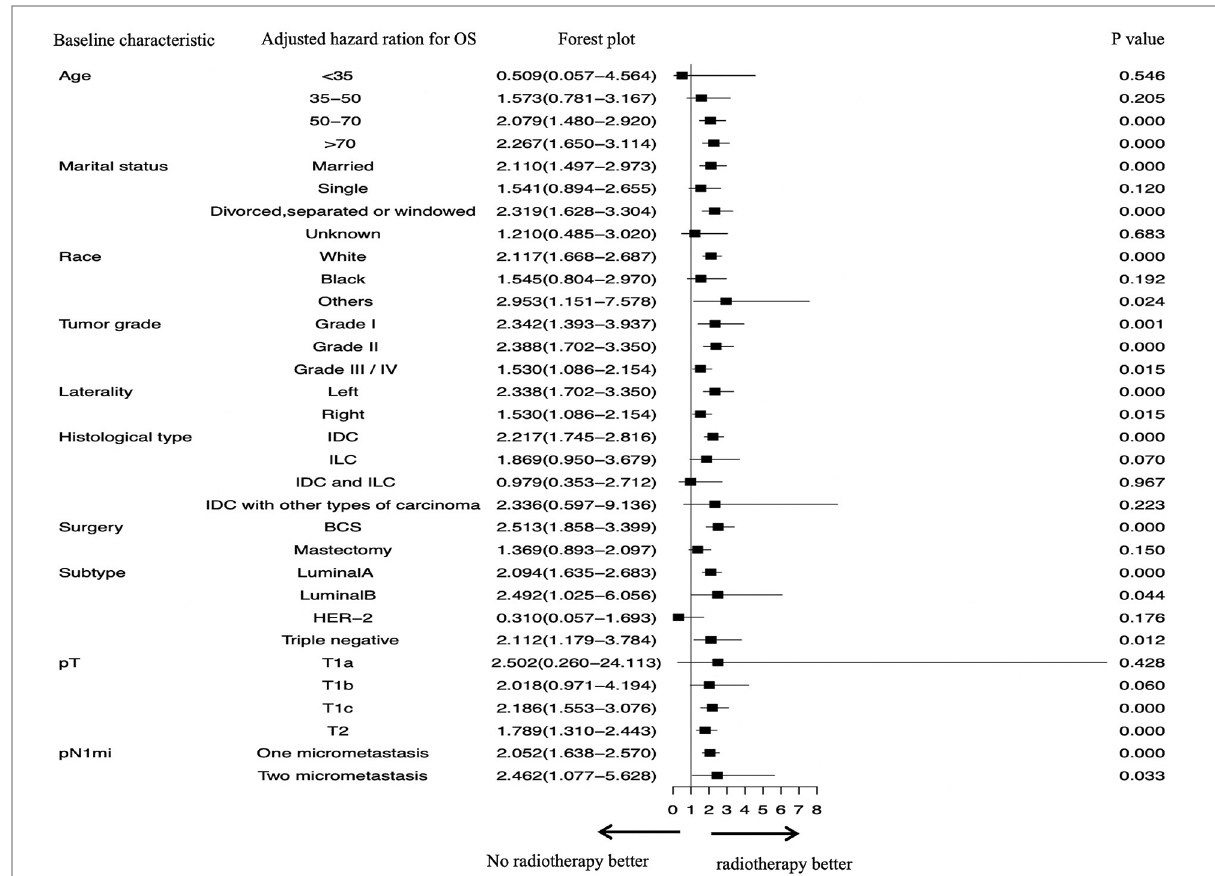
FIGURE 1 Subgroup analyses assessing the bene fi t of radiotherapy in patients who had one or two positive sentinel lymph node micrometastases and underwent sentinel lymph node biopsy alone. SLN, sentinel lymph nodal; SLNB, sentinel lymph node biopsy; IDC, invasive ductal carcinoma; ILC, invasive lobular carcinoma; IDLC, mixed invasive ductal and lobular carcinoma; BCS, breast-conserving